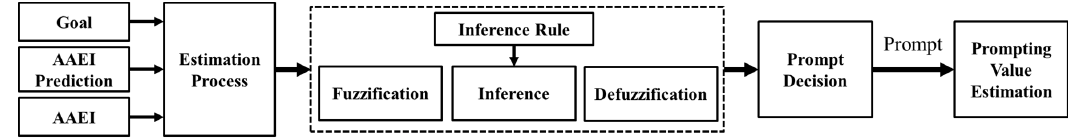
Figure 7. The framework of fuzzy logic prompting system.